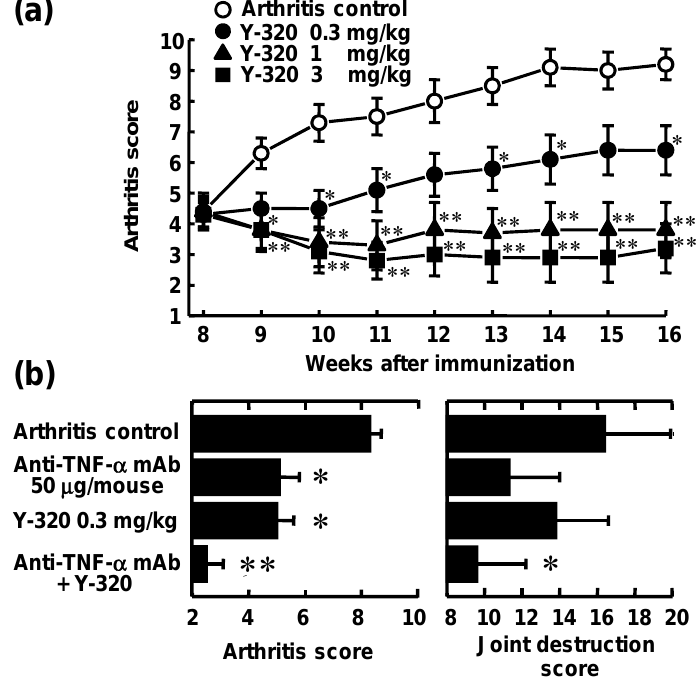
Figure 5. Therapeutic administration of Y-320 ameliorates chronic-progressing CIA in DBA/1J mice. ( a ) Y-320 was administered orally for 8 weeks; ( b ) Y-320 was administered orally for 4 weeks and anti-murine TNF- α mAb was given by a single intravenous injection. Results were expressed as the mean ± SEM of 12 mice. * p < 0.05, ** p <